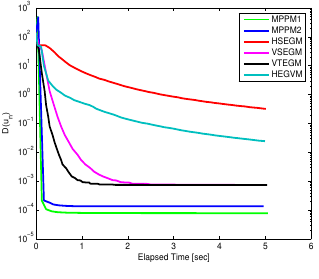
Figure 6. Methods for Example 3 with m = 1. Number of iterations is 48, 59, 48, 58, 107, 57, respectively.